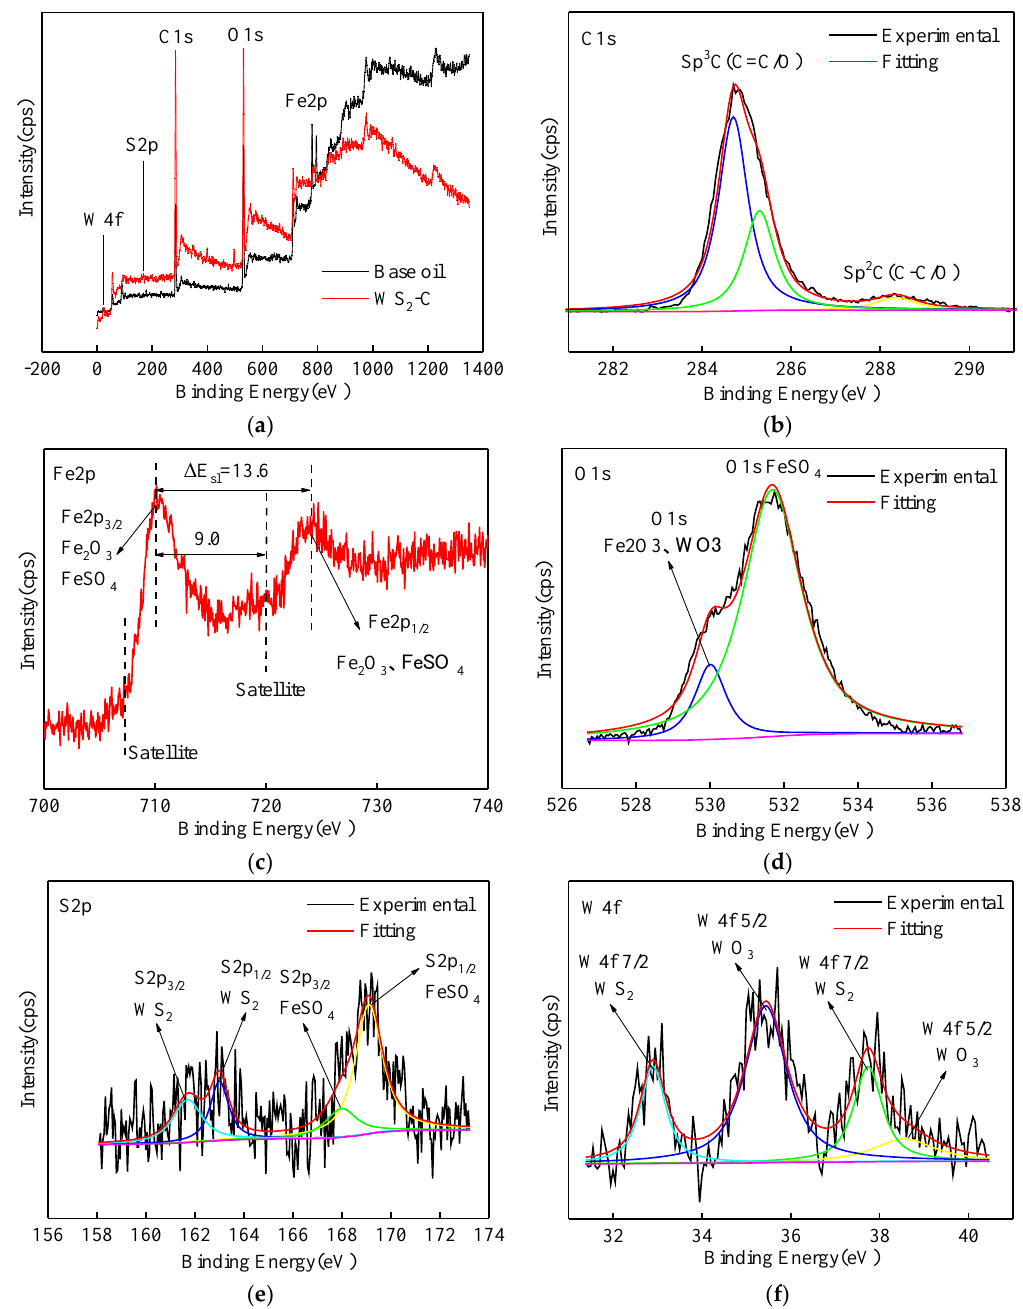
Figure 12. X-ray photoelectron spectroscopy (XPS) spectra from wear scar lubricated with 0.1 wt % WS 2 -C: ( a ) full spectrum; ( b ) C1s; ( c ) Fe2p; ( d ) O1s; ( e ) S2p; ( f ) W4f.